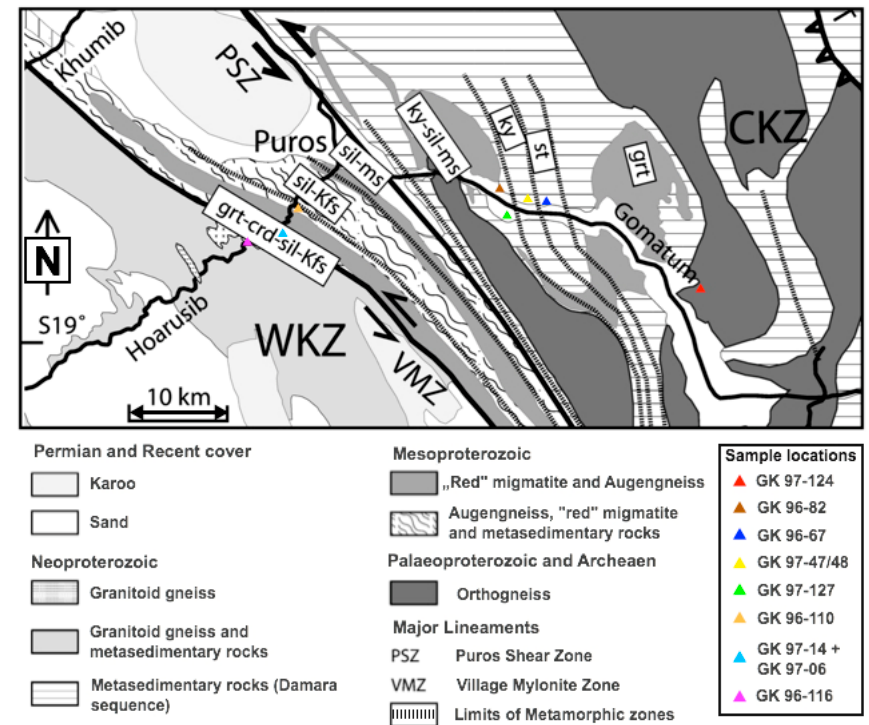
Figure 2. Schematic map of the metamorphic zones along the Gomatum and Hoarusib valleys with sample locations (modified after [34]); grt: garnet zone, st: staurolite zone, ky: kyanite zone, ky-sil-ms: kyanite-sillimanite-muscovite zone, sil-ms: sillimanite-muscovite zone, sil-Kfs: sillimanite-K-feldspar zone, grt-crd-sil-Kfs: garnet-cordierite-sillimanite-K-feldspar zone, WKZ: Western Kaoko Zone; CKZ: Central Kaoko Zone, VMZ: Village Mylonite Zone, PSZ: Puros Shear Zone.